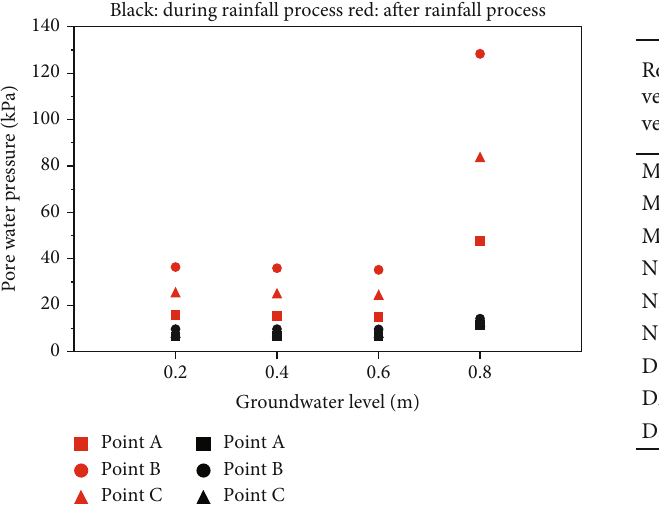
Figure 14: The pore water pressure at slope reference points A,B, and C with retaining wall.